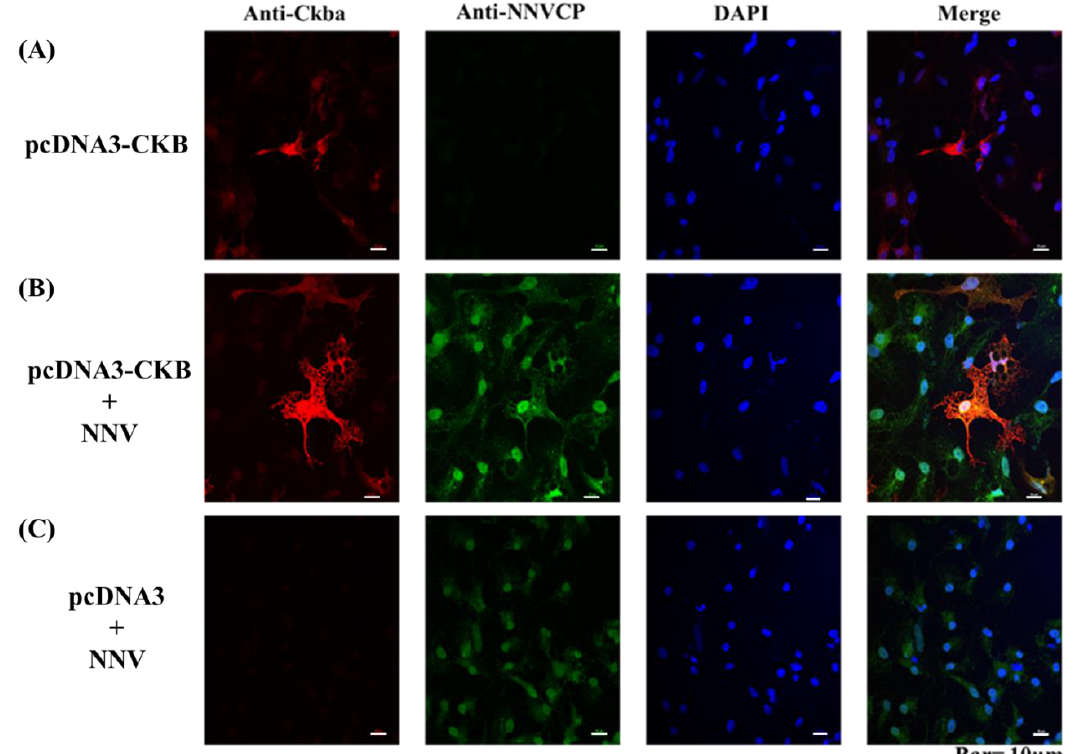
Figure 4. The colocalization between CKB and NNVCP in the GF-1 cell by confocal microscopy. The red fluorescence represents CKB, the green fluorescence represents NNVCP, and the blue fluorescence DAPI represents the nucleus. Colocalization of CKB and NNVCP is indicated in yellow in this merged. ( A ) GF-1 cell transfected with pcDNA3-CKB. ( B ) GF-1 cell transfected with pcDNA3-CKB and infected NNV. ( C ) GF-1 cell transfected with pcDNA3 and infected NNV. Bar = 10 μm.